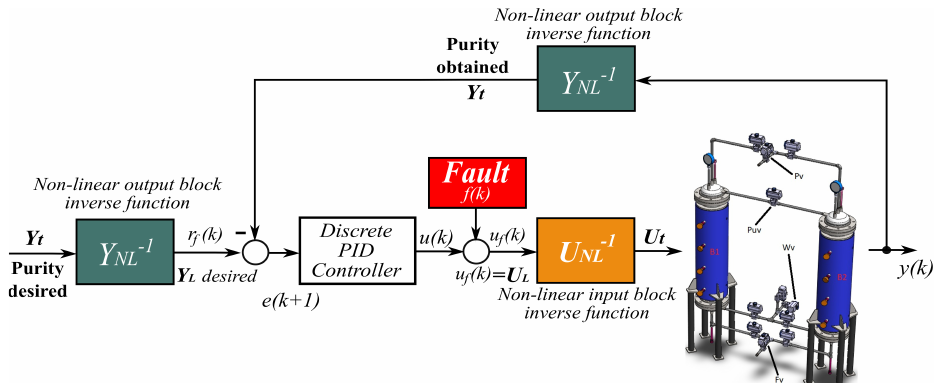
Figure 20. Scenario 2: Discrete PID scheme applied to PSA process.